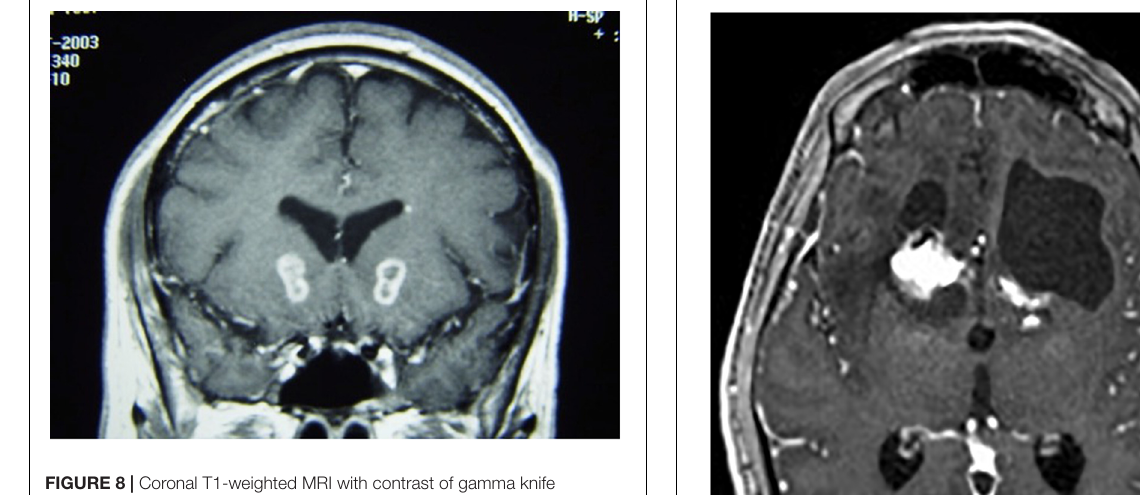
a comparable efficacy to radiosurgical capsulotomy (McLaughlin et al., 2021). Overall responses to LITT are comparable to SRS, but interval to symptom response was much shorter are LITT ( Figure 10